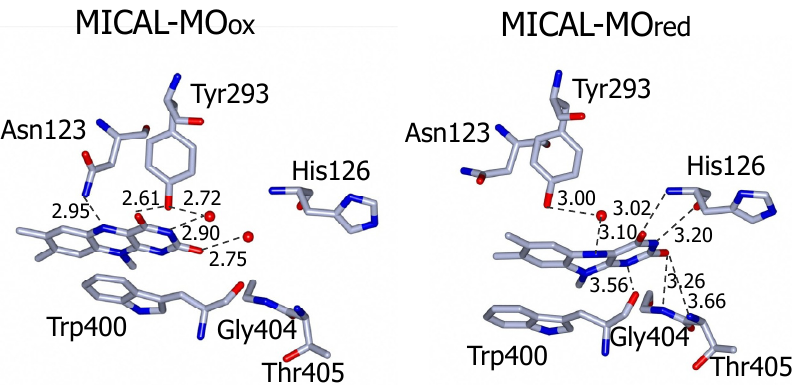
Figure 9. Details of the FAD environment in the “flavin out” and “flavin in” conformations of MICAL-MO. The figure is drawn based on [3]. The view is obtained by vertically flipping the models in Figure 6 with an approximately 45° rotation. The FAD ribityl side chain is cut at C1'. The CCP4MG program was used to generate the figure